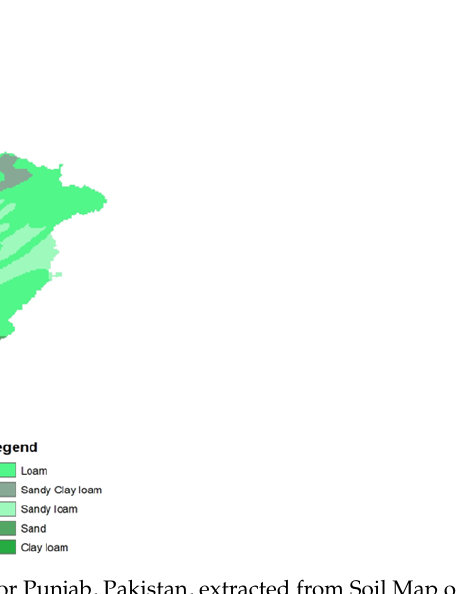
Figure 8. Cropping zones in Punjab, Pakistan [51,52].